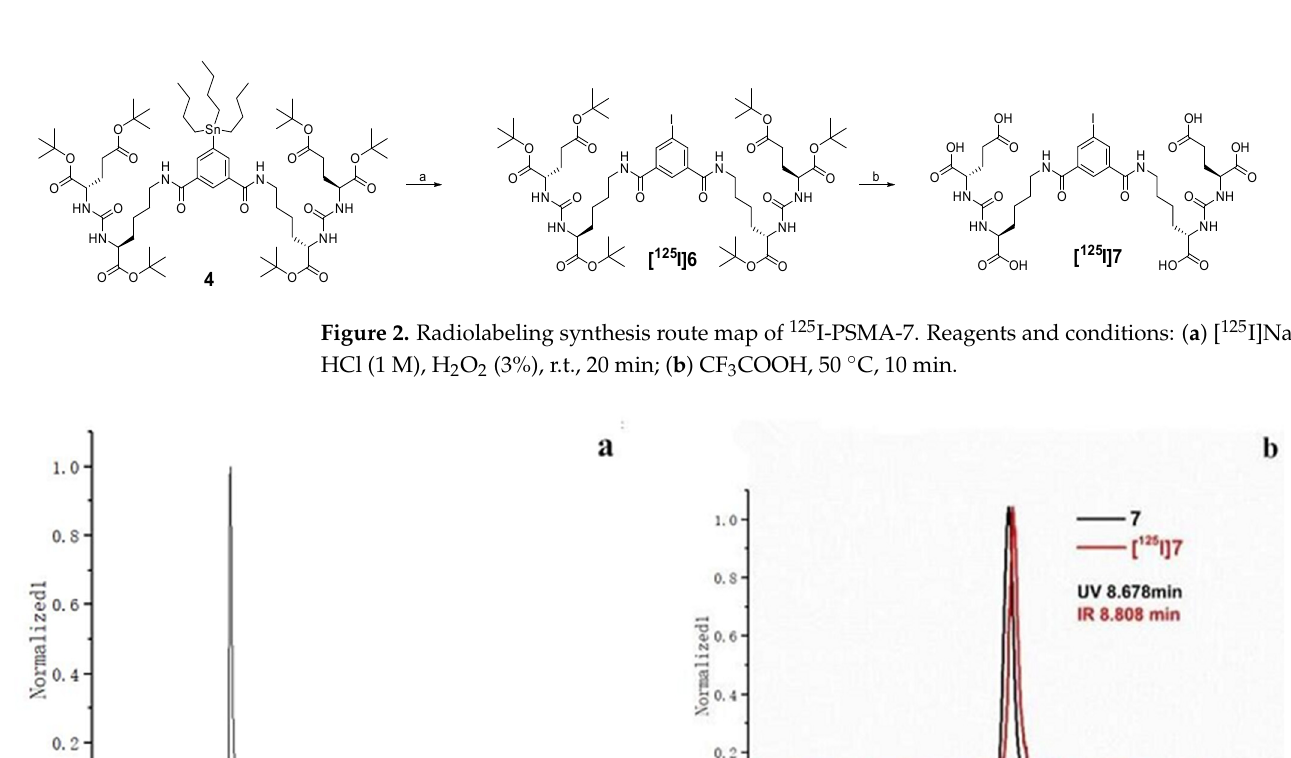
Figure 2. Radiolabeling synthesis route map of 125 I-PSMA-7. Reagents and conditions: ( a ) [ 125 I]NaI, HCl (1 M), H 2 O 2 (3%), r.t., 20 min; ( b ) CF 3 COOH, 50 °C, 10 min.